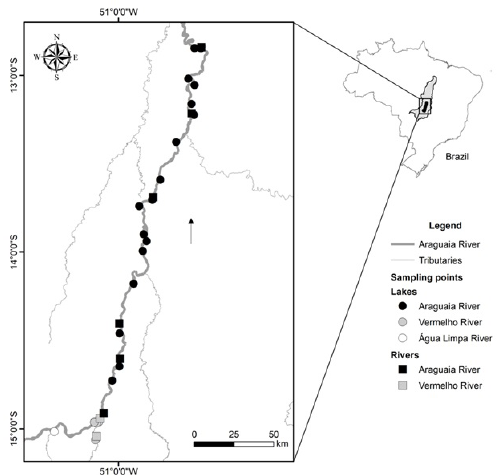
Figure 1. Sampling locations in the Araguaia River floodplain. The same environments (lakes or rivers) were sampled in two periods (January 2006 and July 2006). Two sites were sampled in each